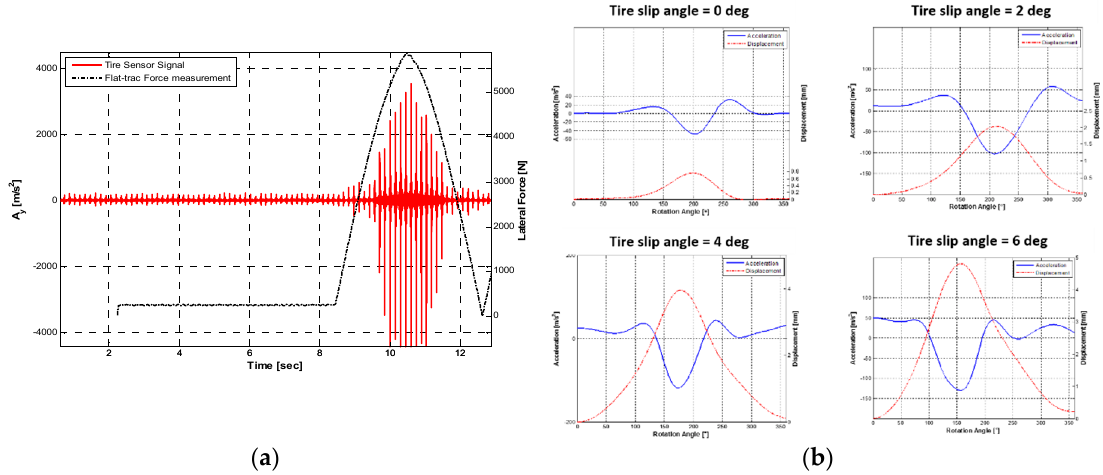
Figure 25. ( a ) Lateral acceleration profile—tire slip angle sweep test and ( b ) recovering lateral displacement of the tire footprint from the acceleration signal at different tire slip angles.